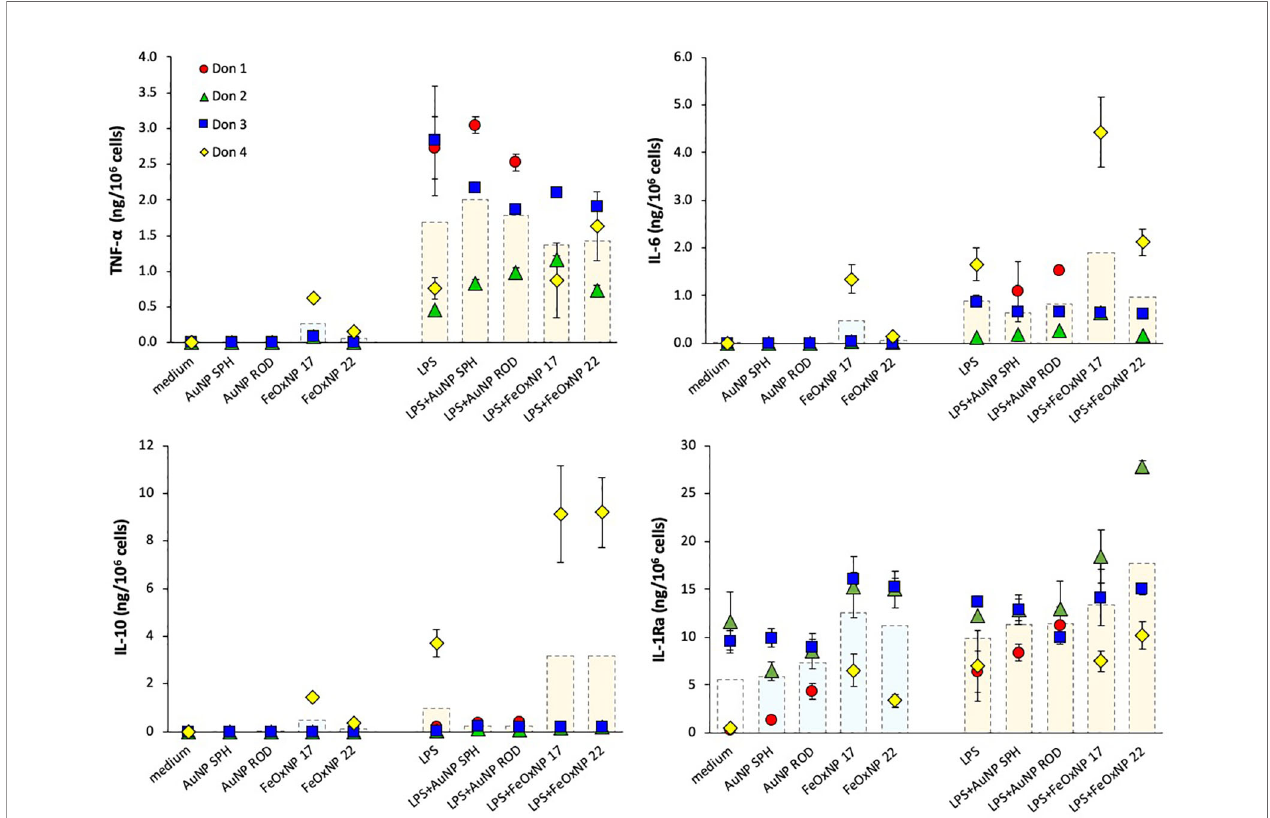
FIGURE 2 | Innate immune primary response of human monocytes to NP alone or upon co-exposure with LPS. Human monocytes isolated from blood of four individual donors (red, green, blue, and yellow symbols) were cultured for 24 h in culture medium alone (empty columns) or containing serum-precoated NP: 5.7 µg/ ml spherical AuNP (AuNP SPH), 1.4 µg/ml rod-shaped AuNP (AuNP ROD), 2 µg/ml spherical FeOxNP of 16.8 nm diameter (FeOxNP 17) and 2.7 µg/ml spherical FeOxNP of 22.4 nm diameter (FeOxNP 22) alone (light blue columns) or together with 1 ng/ml LPS (orange columns). The production of TNF a (upper left), IL-6 (upper right), IL-10 (lower left) and IL-1Ra (lower right) was measured in the 24 h supernatants by ELISA. Data are presented as individual donors ’ values (coloured symbols) ± SD and as mean of the individual values (dotted